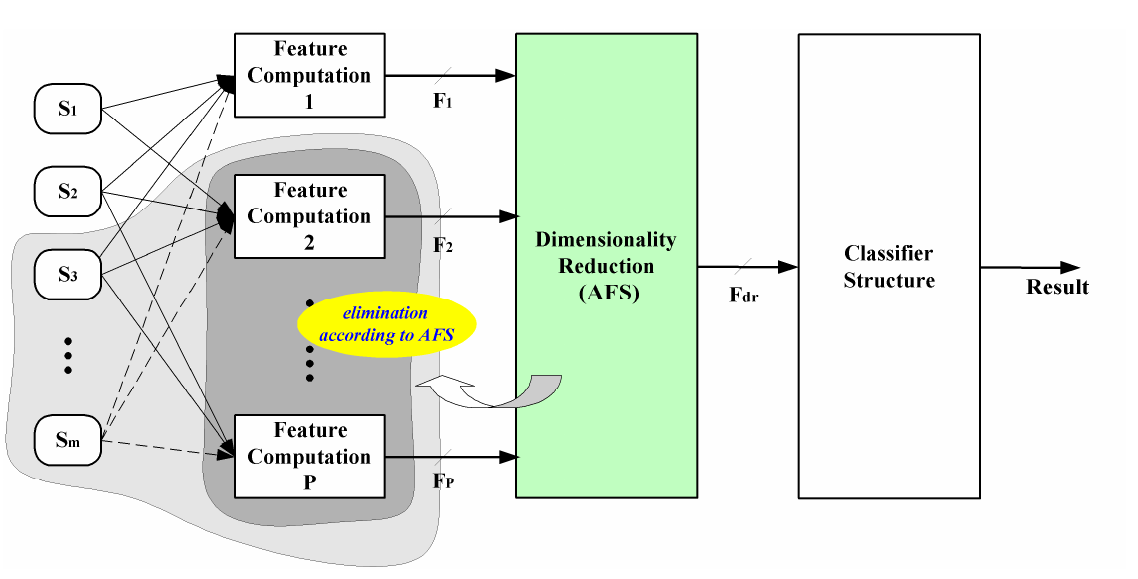
Figure 21. Process of intelligent multi-sensor system design focused on the structure optimization by elimination of redundant feature computation and